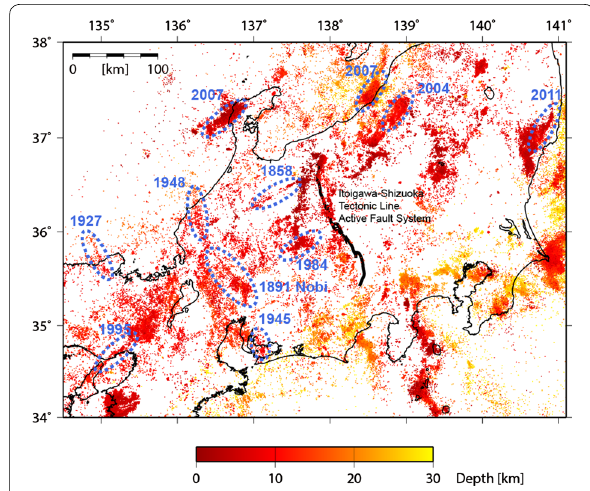
Fig. 3 Hypocenter distribution in central Japan. The dots denote hypocenters of earthquakes shallower than 30 km that occurred in the period of 2006 to 2019. The dot colors indicate hypocenter depth. Predominant earthquake clusters related to large and moderate earthquakes in the last 170 years are shown by ellipsoids with years of earthquake occurrence. The Itoigawa-Shizuoka Tectonic Line active fault system (The Headquarters for Earthquake Research Promotion 2015) is indicated by the solid